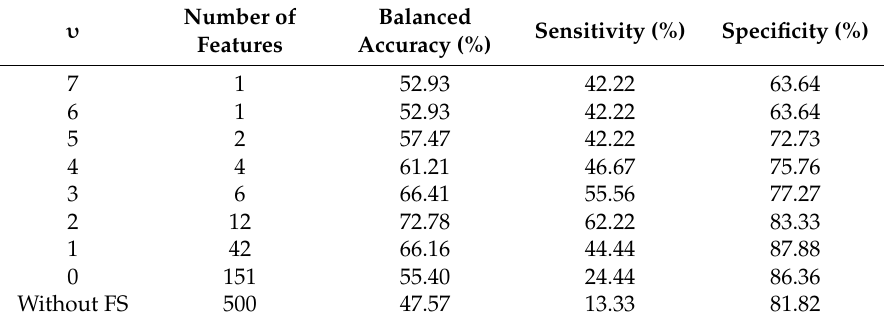
Table 1. The performance using feature with votes larger than a threshold υ .